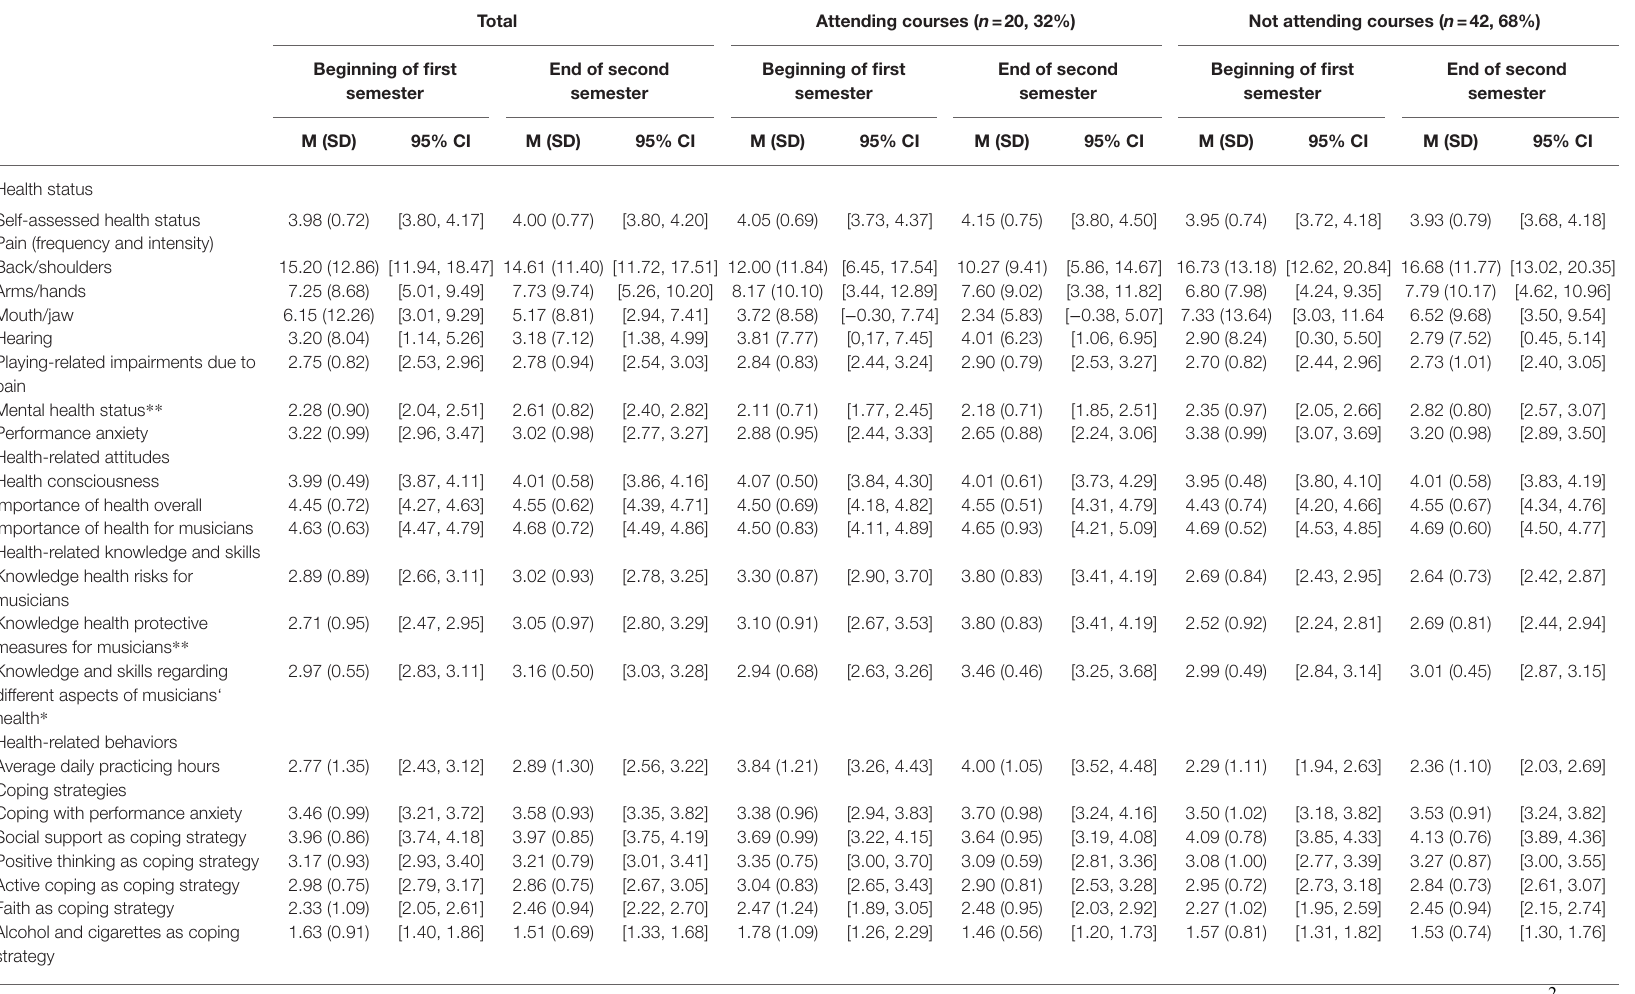
TABLE 4 | Development of health status, health-related attitudes, knowledge, skills and behaviors, and coping strategies over the course of the first two semesters at a music university (students attending and not attending courses on musicians’ health). Total Attending courses ( n = 20, 32%) Not attending courses ( n = 42, 68%) Beginning of first End of second Beginning of first semester semester